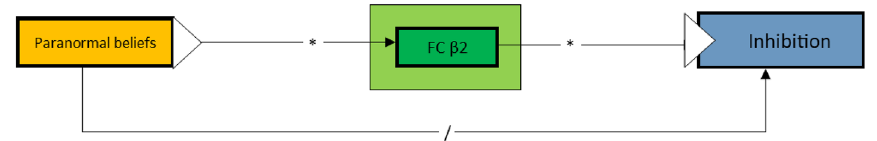
beta2 band in frontal lobe as mediator. FC frontal cortex, β beta band, / insignificant, *Significant in p <